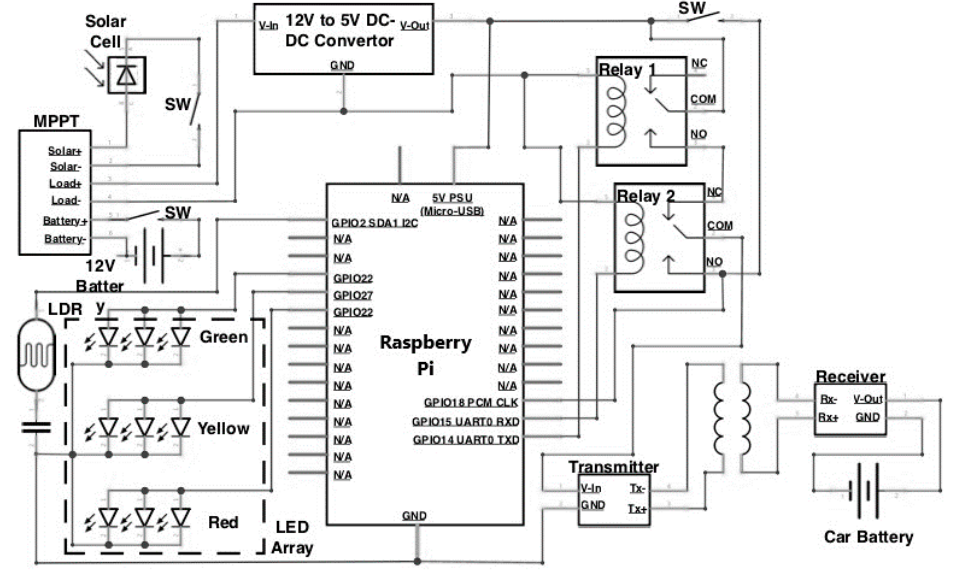
Figure 2. MPPT Charging Algorithm (Adapted from ref. [29]).